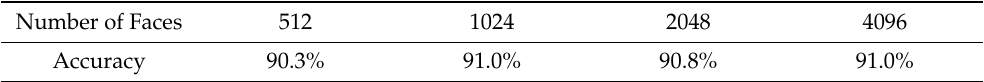
Table 5. Classification results with a different number of faces on ModelNet40.